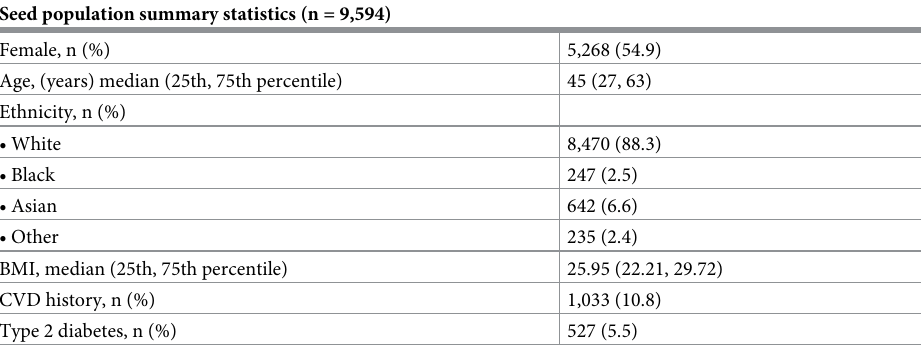
Table 1. Selected baseline characteristics of the initial population.